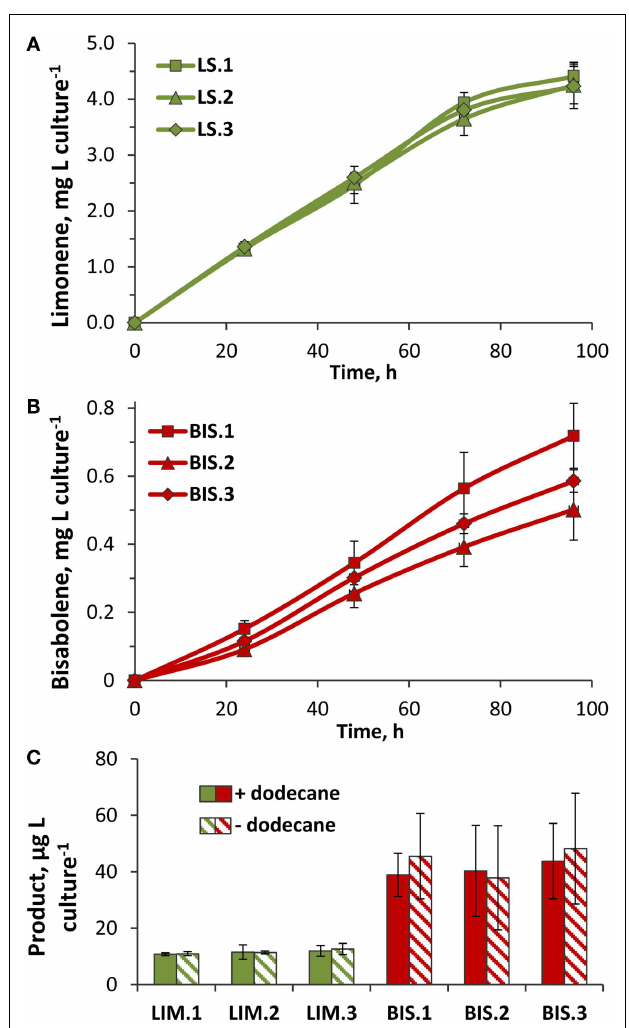
FIGURE 6 | Rates of limonene and α -bisabolene production in transformant lines . (A) Limonene accumulation in three independent LS transformant lines (LS.1, LS.2, and LS.3).Yields were quantified by GC–FID analysis of limonene extracted by a dodecane overlay during the 96-h growth phase ( Figure 5A , + dodecane). (B) α -Bisabolene extracted from three independent BIS lines (BIS.1, BIS.2, and BIS.3) over the 96-h growth phase ( Figure 5B , + dodecane) using a dodecane overlay. (C) Yields of limonene and α -bisabolene extracted from cells harvested after 96h of photoautotrophic growth ( Figure 5 ) in the presence (solid bars) or absence (hatched bars) of a dodecane overlay.Terpenoids were extracted from cells using a methanol:chloroform extraction method, and quantified by GC–FID. Error bars represent standard deviation from at least three biological